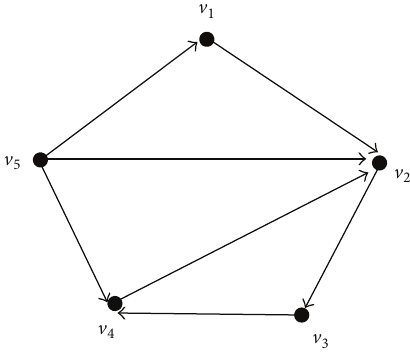
Figure 1: A directed fuzzy communication network of five